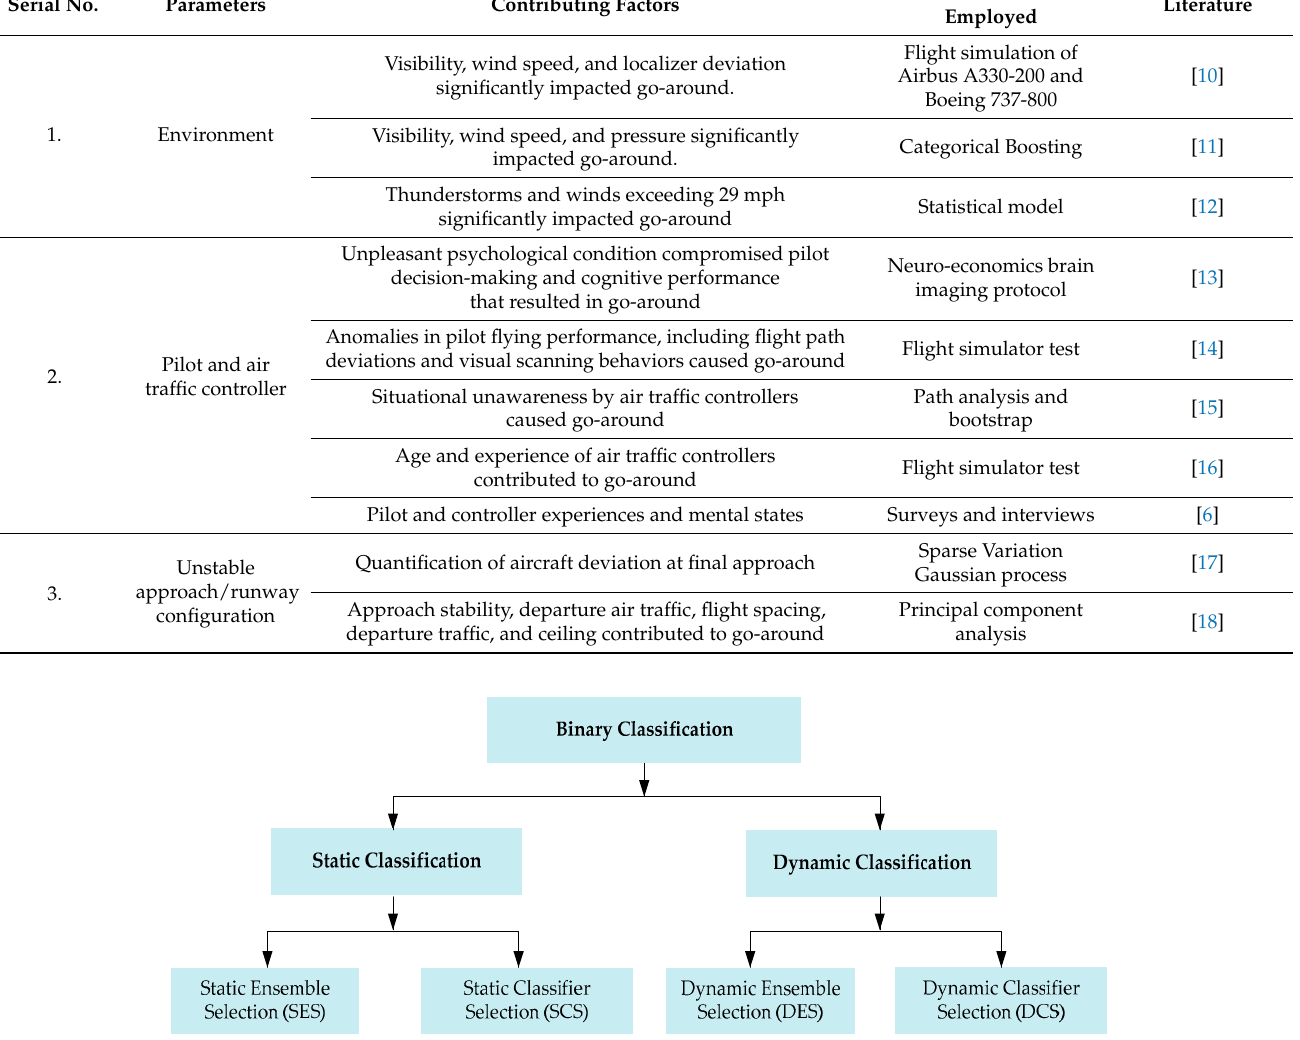
Figure 2. Types of binary classification.